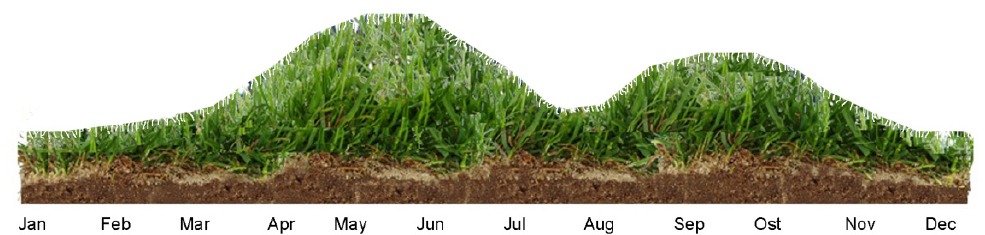
Figure 1. Ideogram of changes in lawn growth intensity during the year in the temperate climate zone (52°12 ′ 58.536 ″ N, 20°38 ′ 43.008 ″ E) expressed as changes in grass height. Winter dormancy usually lasts from half of November until half of March.